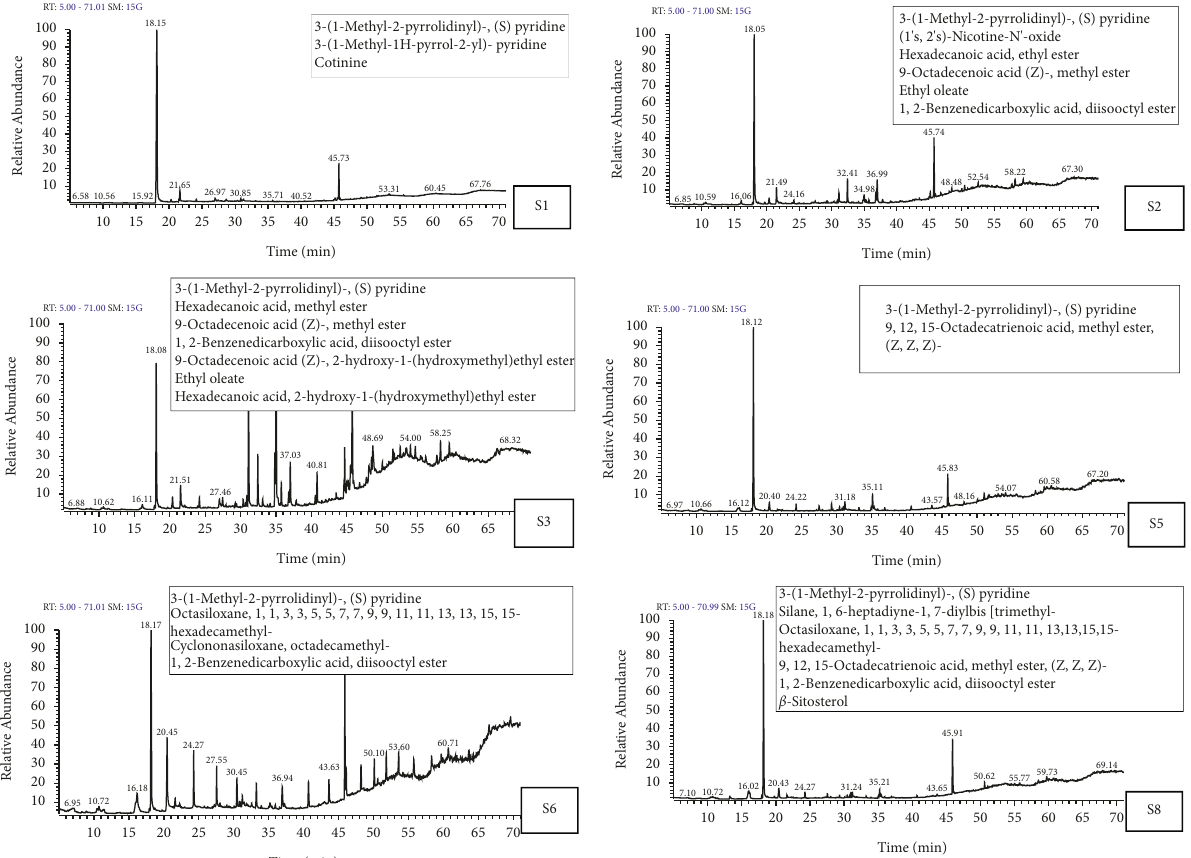
Figure 1: Total ion GC-MS chromatogram of some SLT samples showing (R, S)-nicotine (peak no. 1) with some major bioactive components (chromatograms of all samples are included in the supplementary 3-(1-Methyl-1H-pyrrol-2-yl)-pyridine (3.82%) and tet-